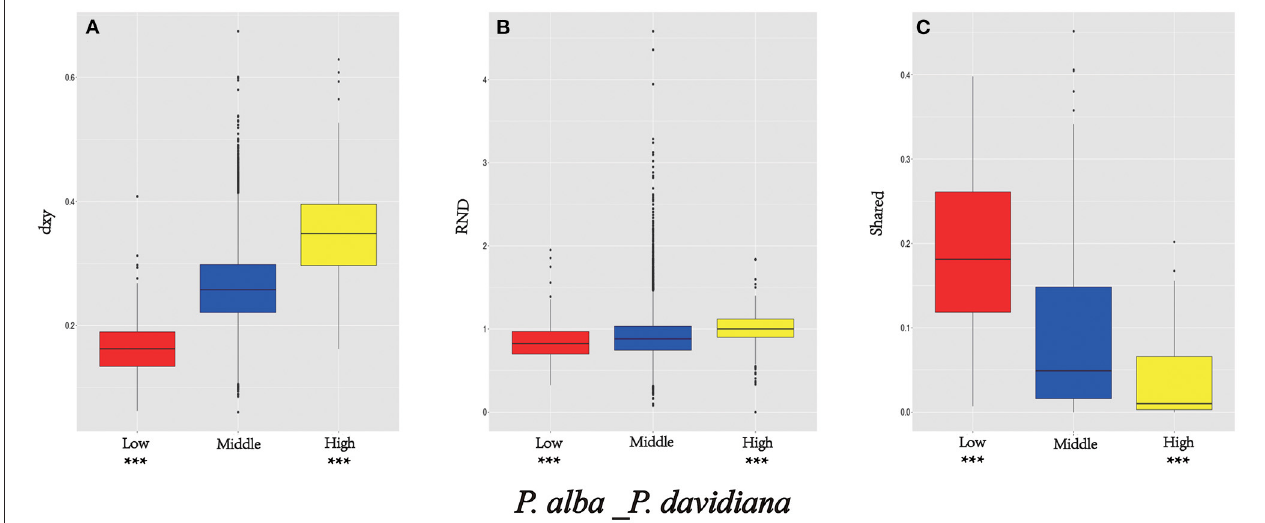
FIGURE 4 | Comparisons of dxy (A) , RND (B) , and shared (C) among regions displaying significantly high (yellow boxes) and low (red boxes) differentiation vs. the genomic background (blue boxes) between P. davidiana and P. alba . Asterisks designate significant differences between outlier windows and the rest of genomic regions by Mann-Whitney U test (*** P -value < 2.2e–16).